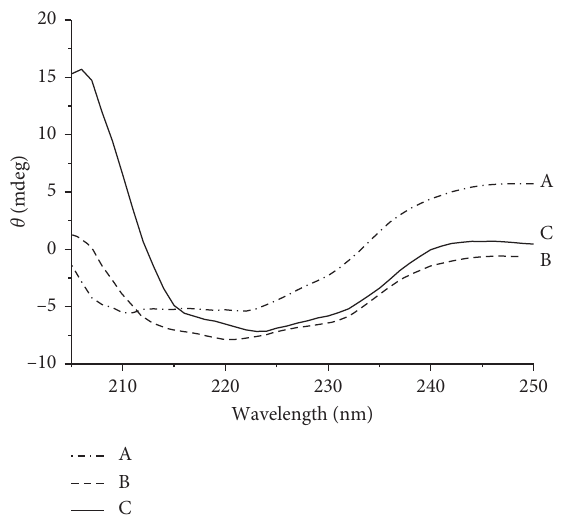
Figure 4: The CD spectra of (A) lysozyme, (B) lysozyme-luteolin, and (C) lysozyme-luteoloside. C